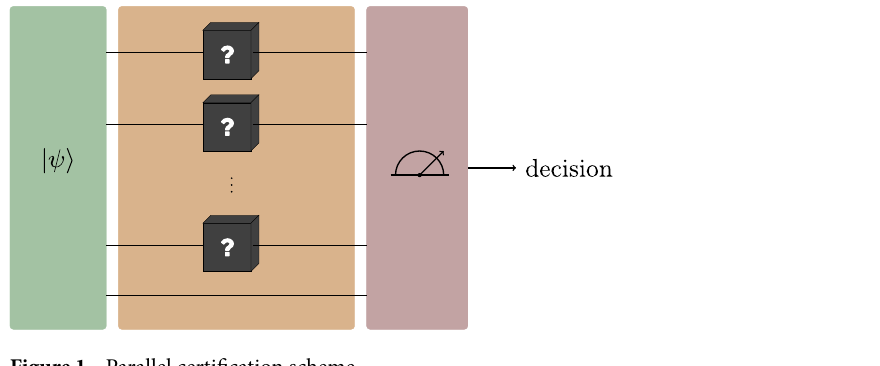
Figure 1. Parallel certification